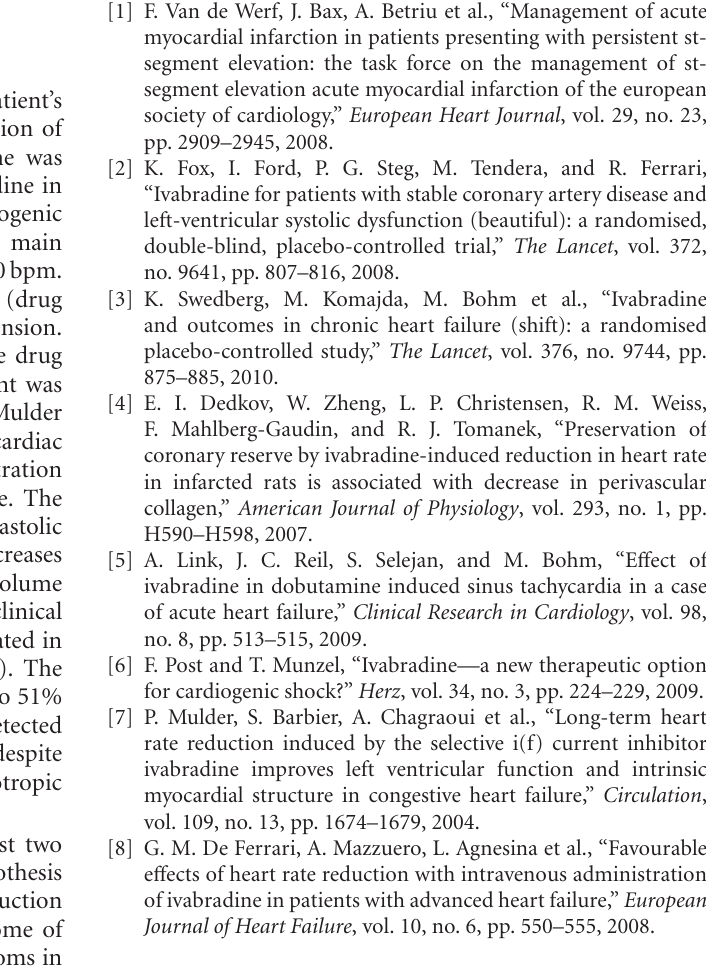
Figure 3: Inflammatory cardiomyopathy with mononuclear infil- tration in histopathological